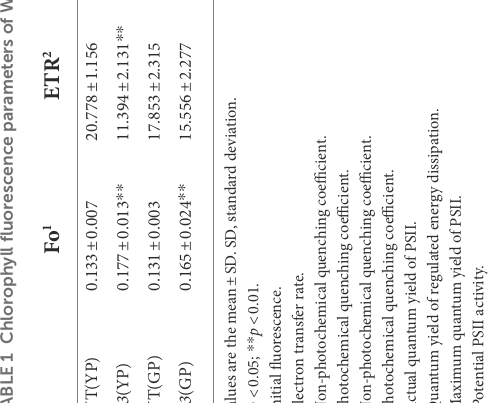
Supplementary Table 2. The region obtained by BSA-Seq was consistent with the linkage region. Finally, v-3 was mapped to the 1.34 Mb region of chromosome 3 (Supplementary Table 3). T A